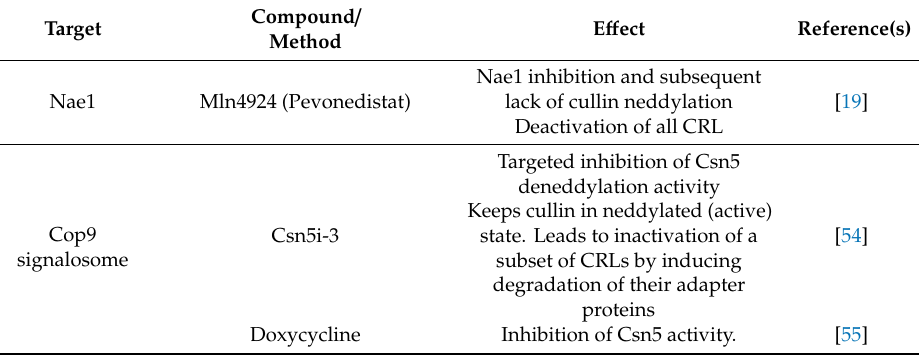
Table 1. Pharmacological and experimental modulation of cullin-RING ligase (CRL) activity. This